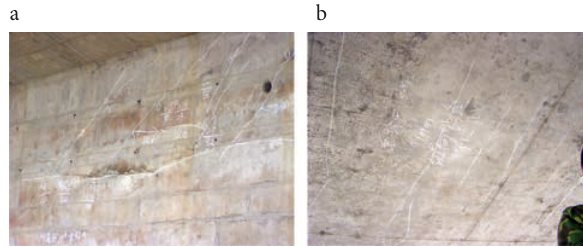
Fig. 9. Cracks: a – inclined cracks in web; b – longitudinal cracks in bottom slab (from Wang J.)